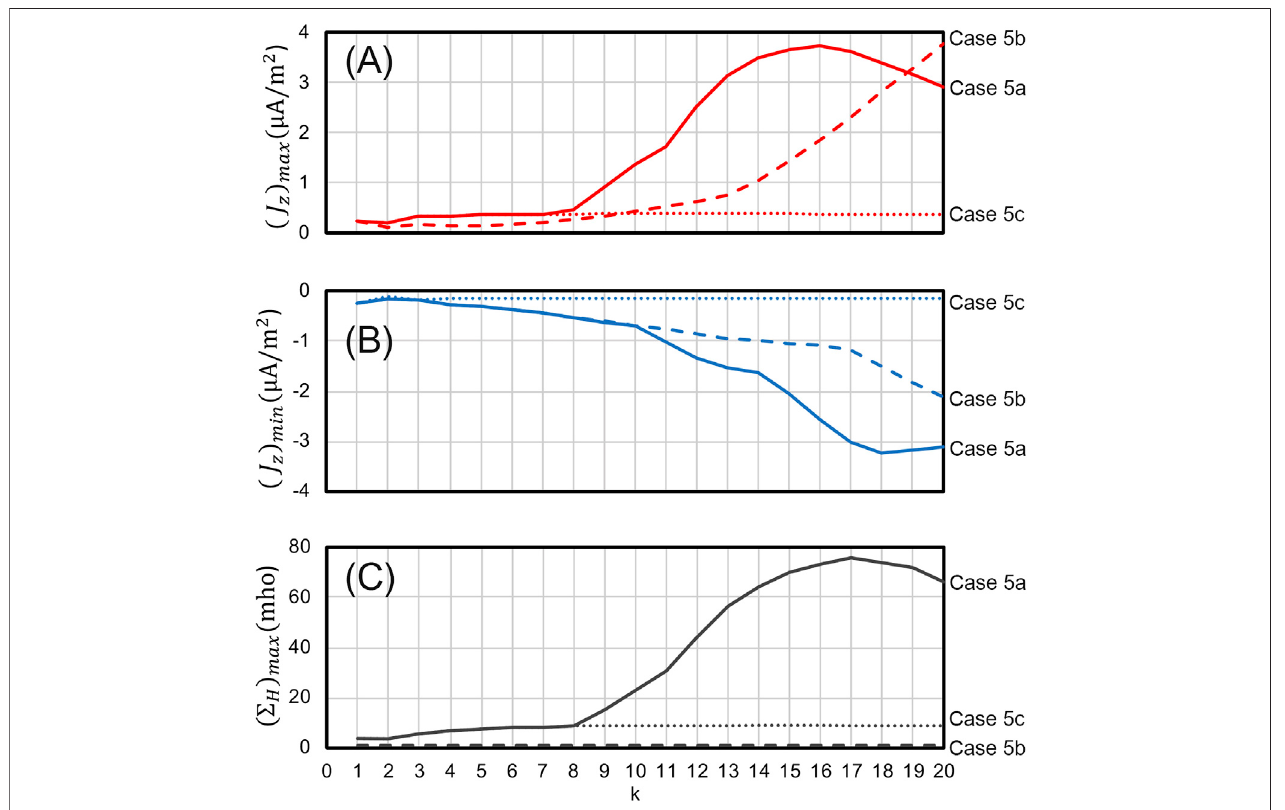
FIGURE7| Thetime evolutionof (A) ( J z ) max , (B) ( J z ) min , and (C) ( Σ H ) max obtainedfrom thesimulations ofCase 5a(the solidcurves), Case5b(the dashed curves), and Case 5c (the dotted curves). Simulation Cases 5a, 5b, and 5c are characterized byuniform lowconductances ( Σ H (cid:1) 1mho) at the beginning of the simulations. The conductance enhancement scheme is turned off in the simulation study of Case 5b. The plasma sheet Hall effect is turned off in the simulation study of Case 5c.